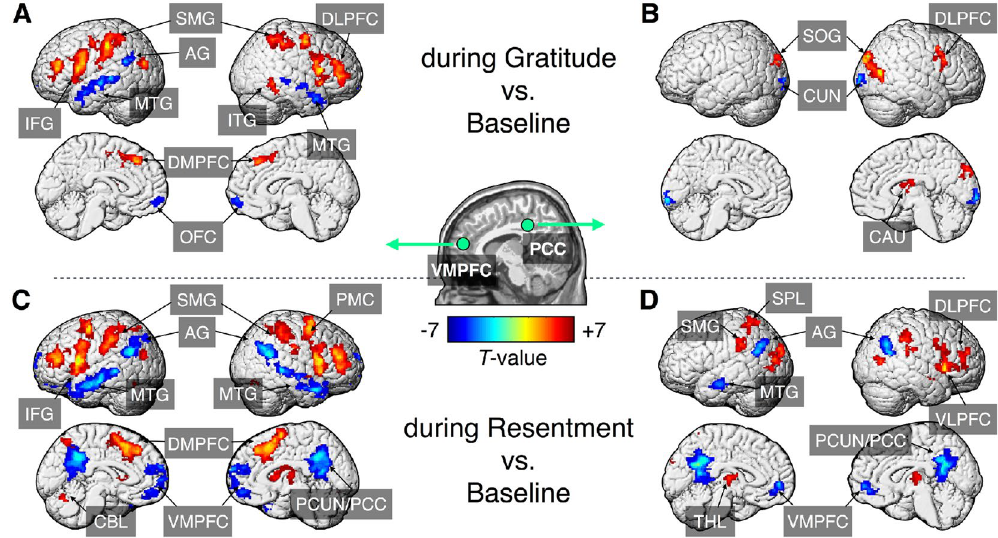
Figure 2. Alterations in resting-state functional connectivity during the gratitude ( A and B ) and resentment ( C and D ) interventions compared to baseline. Volume-rendered results were mapped with t-statistics for the two seed regions: ( A and C ) ventromedial prefrontal cortex (VMPFC) and ( B and D ) posterior cingulate cortex (PCC). Peak coordinates and statistical values of the clusters are summarized in Supplementary Tables S4 and S5. Abbreviation: AG, angular gyrus; CBL, cerebellum; CUN, cuneus; DLPFC, dorsolateral prefrontal cortex; DMPFC, dorsomedial prefrontal cortex; IFG, inferior frontal gyrus; ITG, inferior temporal gyrus; MTG, middle temporal gyrus; PCC, posterior cingulate cortex; PCUN, precuneus; PMC, premotor cortex; SMG, supramarginal gyrus; SOG, superior occipital gyrus; SPL, superior parietal lobule; THL, thalamus; and VLPFC, ventrolateral prefrontal